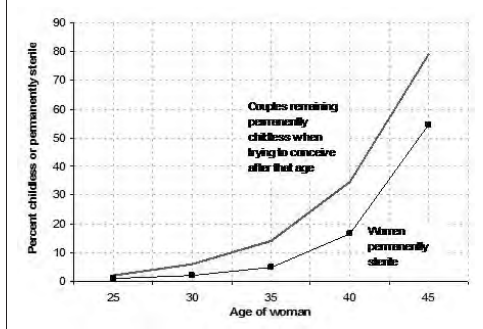
Figure 2: Percentage of women who are per- manently sterile and of couples remaining childless at age 50 when trying to